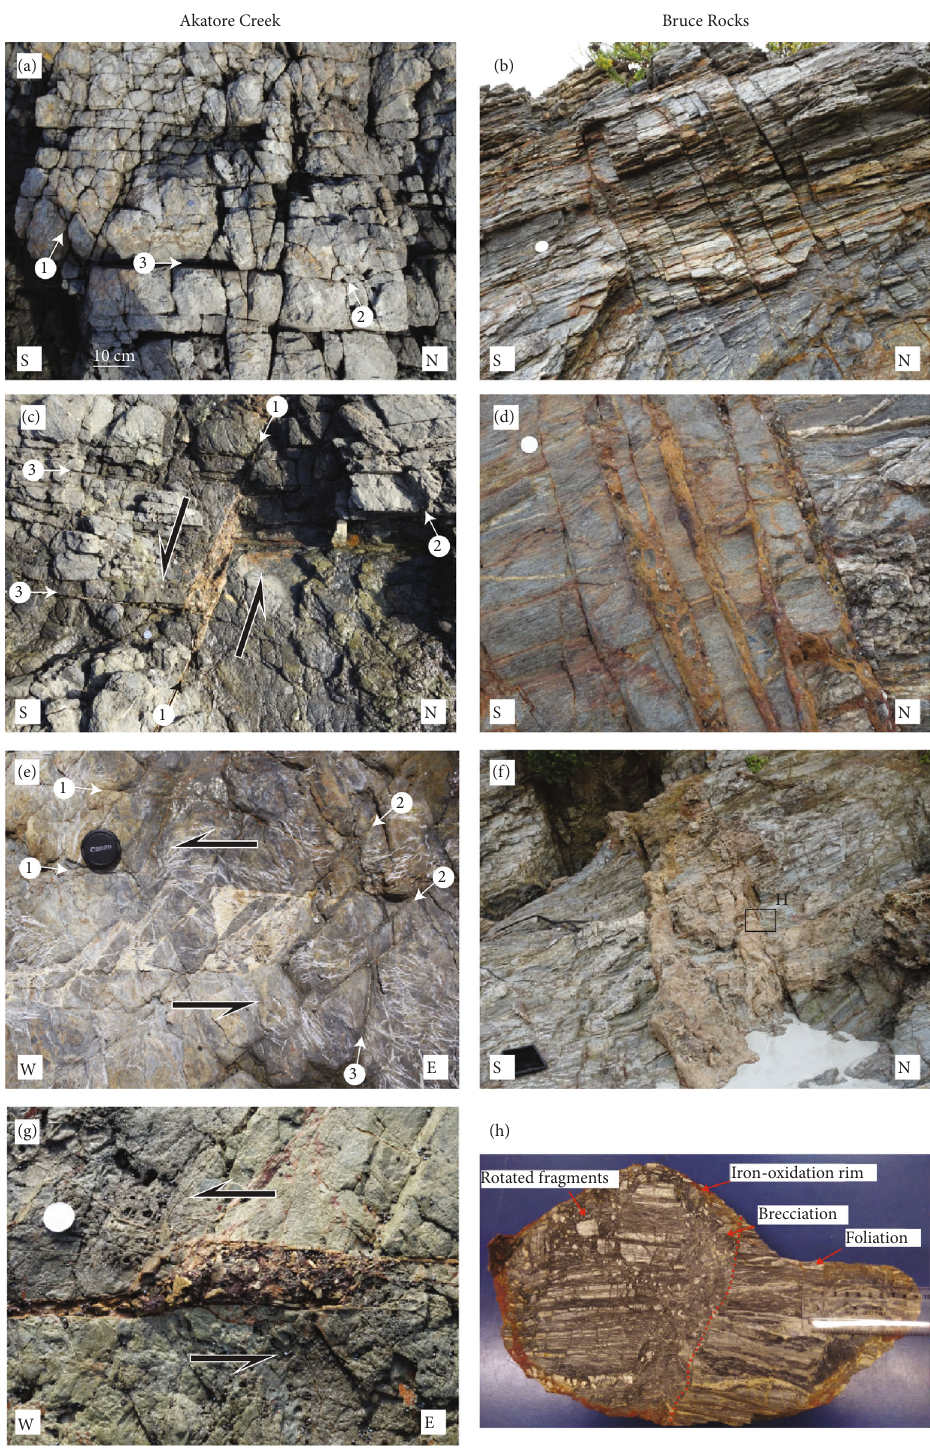
Figure 4: Photos from Akatore Creek (left column) and Bruce Rocks (right column). (a) Three main sets of exhumation joints are mutually intersecting at Akatore Creek. Spacing of joints varies between a few centimetres (in this photo) and a few metres (Figure 3). (b) One main set of steeply N-dipping joints at Bruce Rocks cuts across the prominent metamorphic foliation. (c) Reactivation of joint sets 1 and 3 has formed a carbonate- fi lled dilational jog. Joint set 2 is not reactivated in this case. (d) Reactivation of joints at Bruce rocks produce tabular layers of orange, carbonate-cemented fault breccias. (e) Formation of a rhomb-shaped carbonate- fi lled mosaic breccia at Akatore Creek, by reactivation of joint sets 1 and 2. (f) A relatively large fault at Bruce Rocks is surrounded by an orange, carbonate-bearing alteration zone. (g) Rhomb-shaped fault breccia at Akatore Creek containing fragments of calcite veins. (h) Polished hand specimen of fault breccia from Bruce Rocks, containing rotated angular fragments of Otago